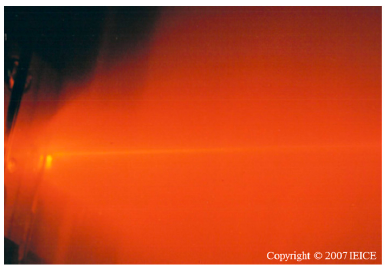
Figure 10. World’s shortest AlGaInP laser diodes (615 nm) oscillating at room temperature, adapted from [71], with copyright permission from © 2007 IEICE.